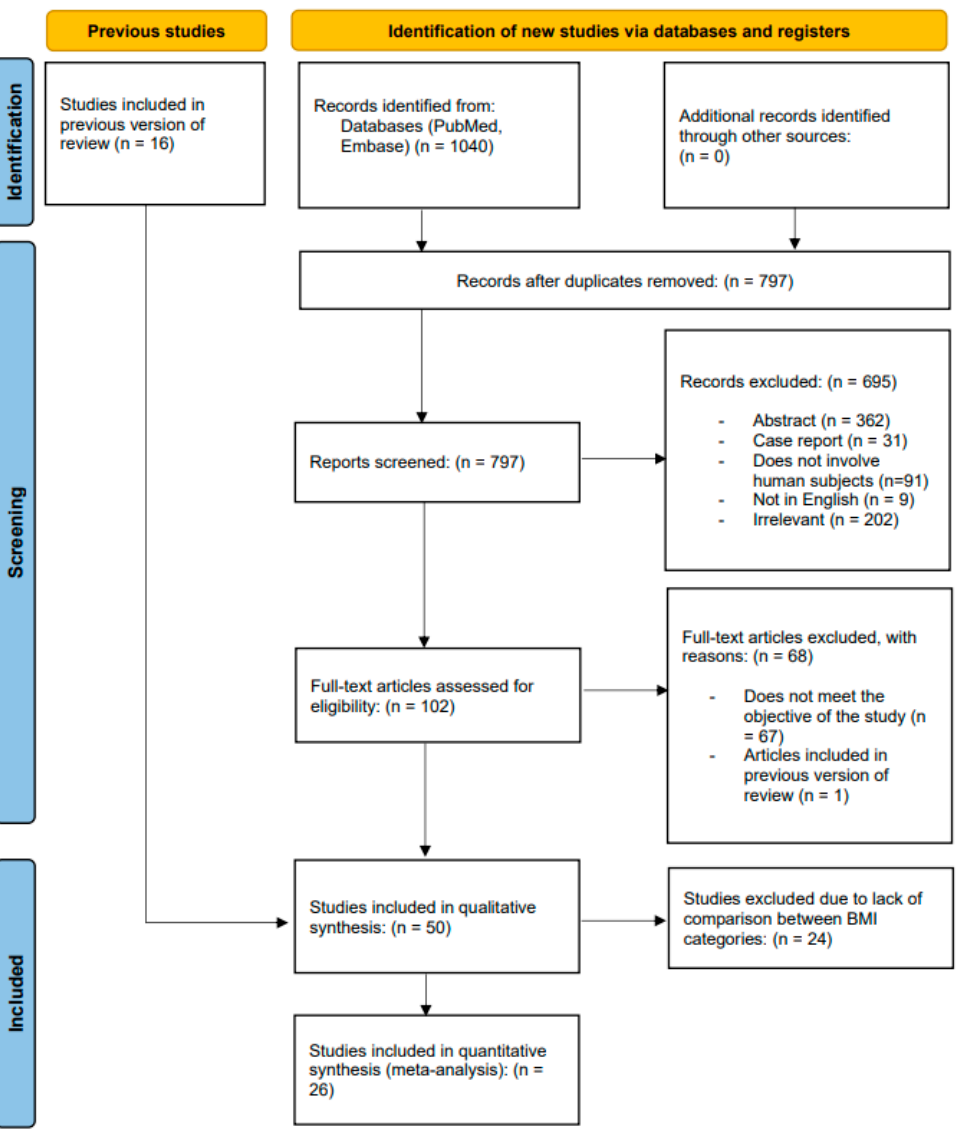
Figure 1. Preferred Reporting Items for Systematic Reviews and Meta-Analyses (PRISMA) flow diagram of the study selection process. Table 1. Summary of the included studies.